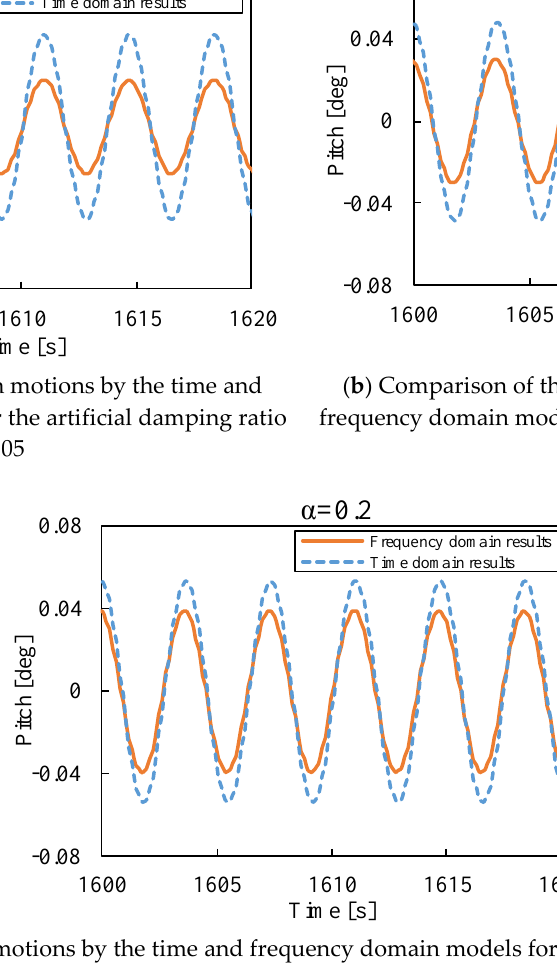
Figure 19. Pitch response of the windward module in the frequency domain and time domain under different artificial damping α subjected to the regular wave ( H = 1 m, ω = 1.7